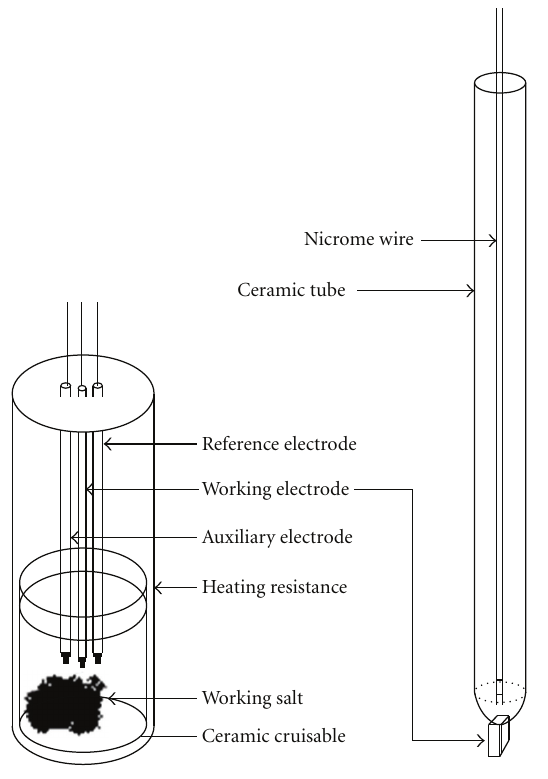
Figure 1: Schematic diagram showing the experimental setup.